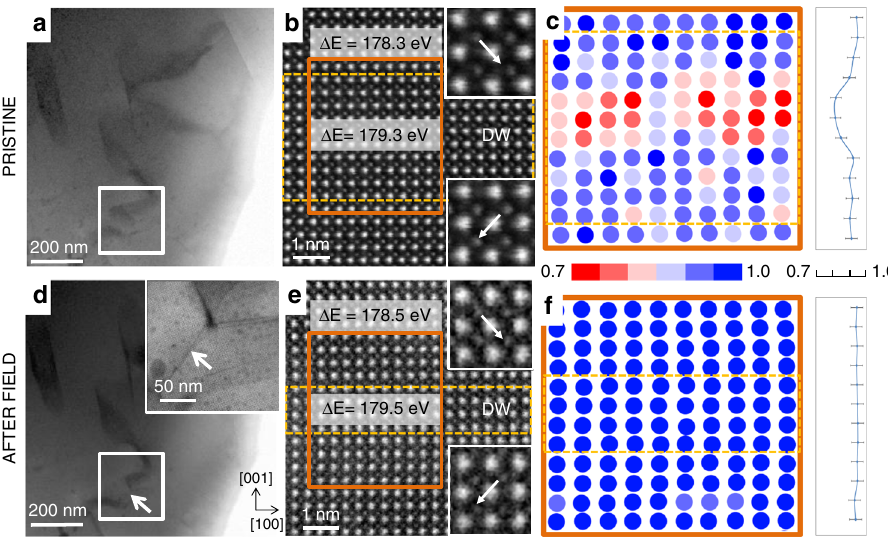
Fig. 1 Redistribution of defects at DWs by application of electric fi eld as observed on the atomic scale. Images of domains and atomic-scale DW analysis a – c before and d – f after the application of the electric fi eld to the BiFeO 3 sample. Bright- fi eld (BF) STEM images of domains in the same region in BiFeO 3 before and after the application of the electric fi eld are shown in panels a and d , respectively. The sample region where signi fi cant changes were observed after the fi eld application is highlighted with white boxes. The inset of panel d shows an enlarged view of the newly formed DW (marked with arrow), appearing as a result of the applied electric fi eld. HAADF-STEM image in [010] zone axis of a 109° DW before the application of the electric fi eld and of the newly formed 109° DW after fi eld application is provided in panels b and e , respectively. The insets of these panels show the Fe displacement directions (relative to the Bi sublattice) in the two adjacent domains where dashed-yellow boxes indicate DW regions. Experimental EELS spectra were acquired on and off these DW regions, as indicated by grey bands in panels b , e with labelled energy onset difference ( Δ E) between the O-K and Fe-L 3 edges. Normalized distribution maps of Bi-column intensities with the corresponding average intensity line pro fi les before and after the application of the electric fi eld are shown in panels c and f , respectively. These regions correspond to those marked with full orange boxes in panels b, e . Individual colours in the scale bar represent 0.05 steps in Bi-column intensities. Error bars in the intensity line pro fi les in panels c , f represent the standard deviation of the intensity measurements performed inside domain regions (~4%